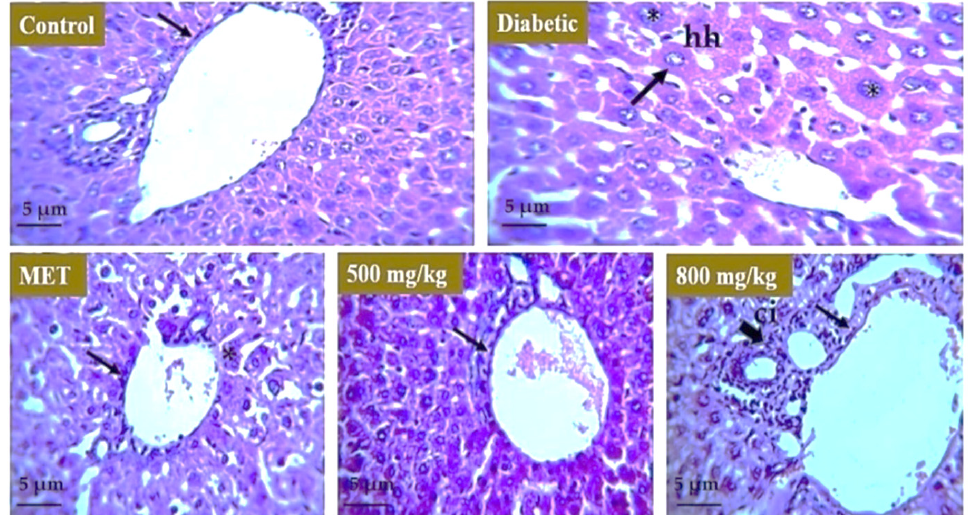
Figure 8. Effect of aqueous extract on the liver tissue. The liver of control mice group revealed intact hepatic portal vein and no hypertrophy in cells. Diabetic mice liver revealed hepatocyte hypertrophy and vein distortion (arrows). Metformin-treated mice revealed improvement in morphology of liver tissue (*). Furthermore, 500 mg/kg TS-AQ dose-treated mice showed restoration of normal structure of liver and size of hepatocyte was restored (*), and 800 mg/kg TS-AQ-treated mice revealed improvement in restoration of normal morphology of liver but there was some cellular infiltration (arrow). hh = hepatocyte hypertrophy. ci = cellular infiltration.